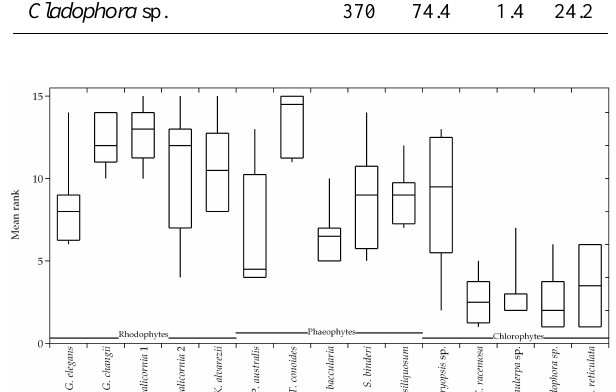
Fig. 4. Production rank box and whisker plots for all halocar- bons emitted by each seaweed species. Production data in pmol in gFW − 1 h − 1 at t 24 were used to rank the seaweeds for their pro- duction of each halocarbon. The lower and upper limits of the boxes represent the 25th and 75th percentiles, the horizontal lines are me- dian values and whiskers represent the 10th and 90th percentiles. Species are ordered by class (rhodophyte, phaeophyte, chlorophyte) and alphabetically with these groups.